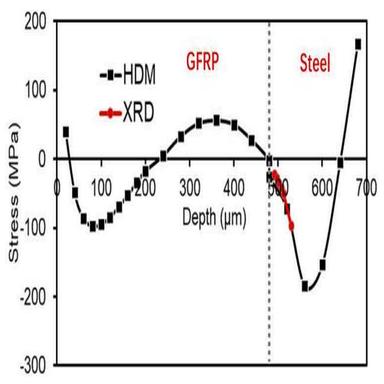
Comparison of residual stresses σx in GFRP/Steel/GFRP experimentally determined by ED-XRD and IHD.